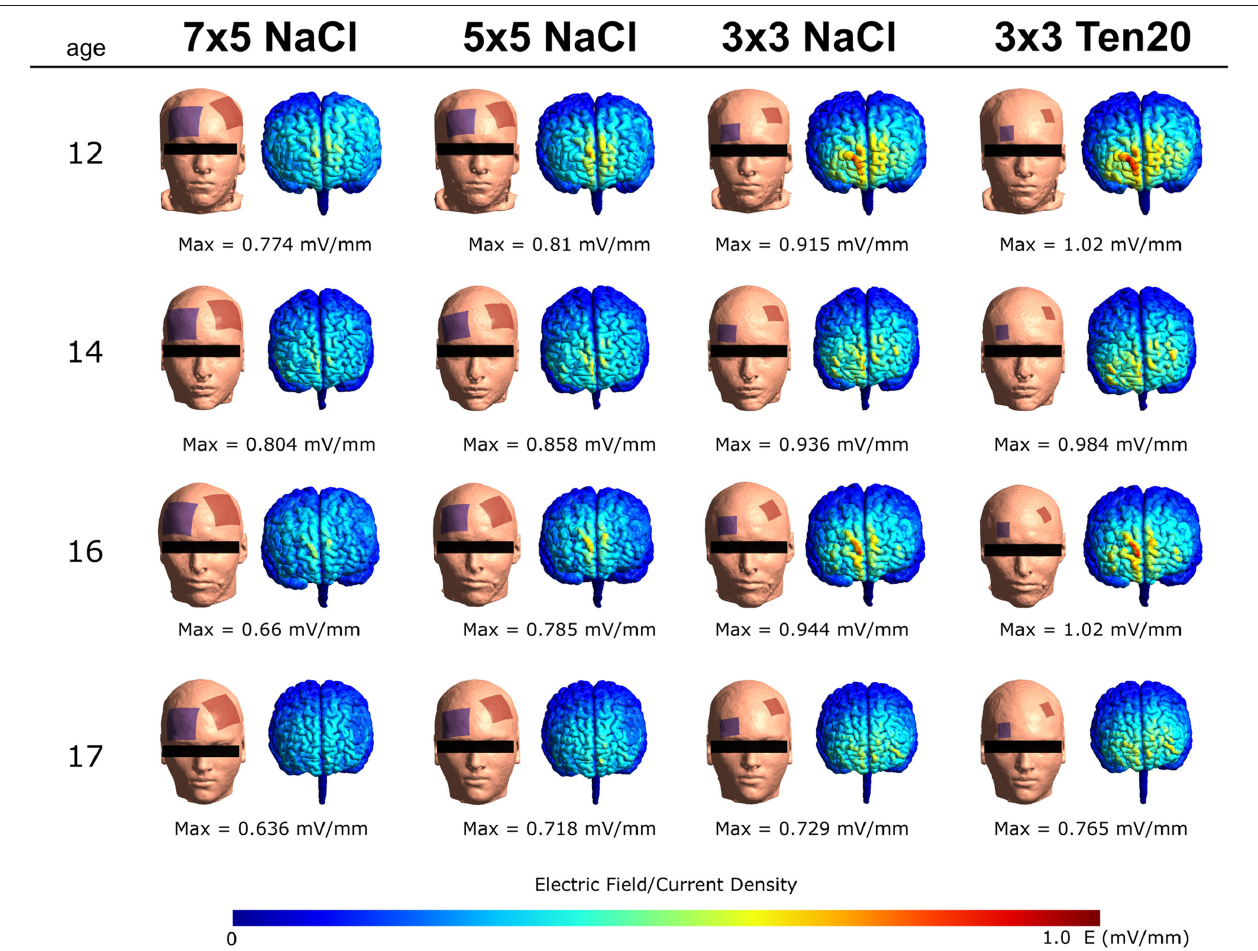
FIGURE 2 | Four examples of the simulations of our tDCS protocol in adolescents using SimNIBS and previously acquired T1-weighted MRI scans of a comparable population. The electric field was simulated using bilateral montages (anode at F3 and cathode Fp2-supraorbital), an intensity of 2mA, and three different electrode sizes. Each row represents one participant and each column represents one montage. Peak magnitudes of the intracranially generated electric fields are listed below each simulated